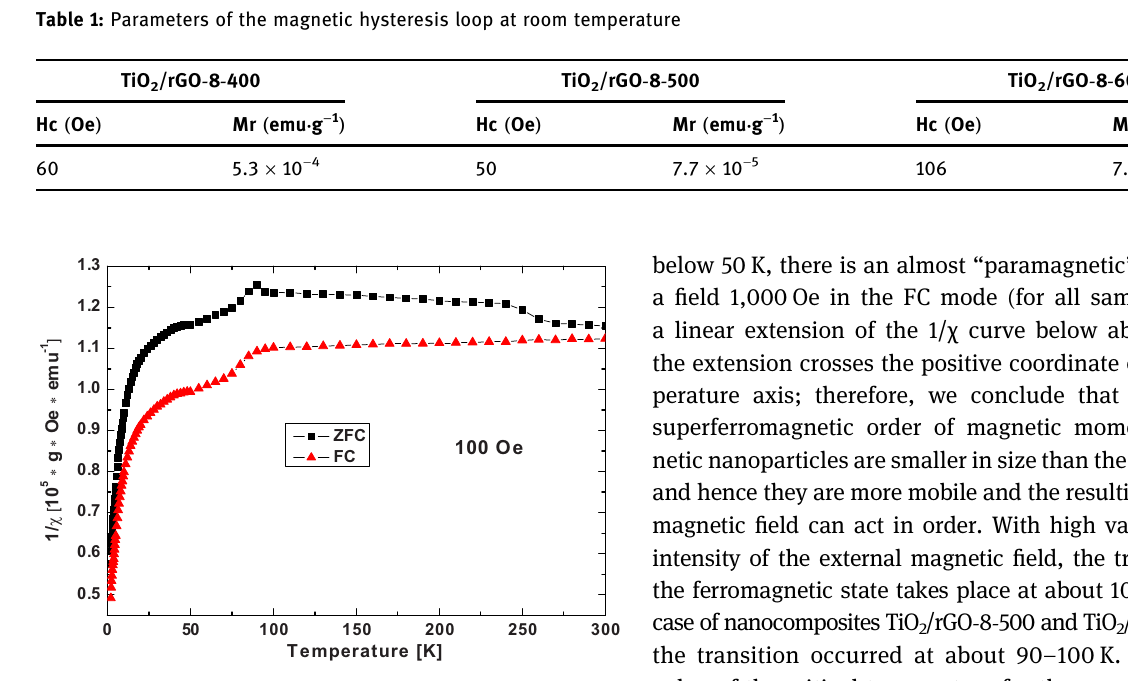
Figure 3: Temperature dependence of inverse magnetic suscept - ibility in ZFC and FC modes for the nanocomposite TiO 2 /rGO - 8 - 400 at an applied magnetic fi eld H = 100 Oe.